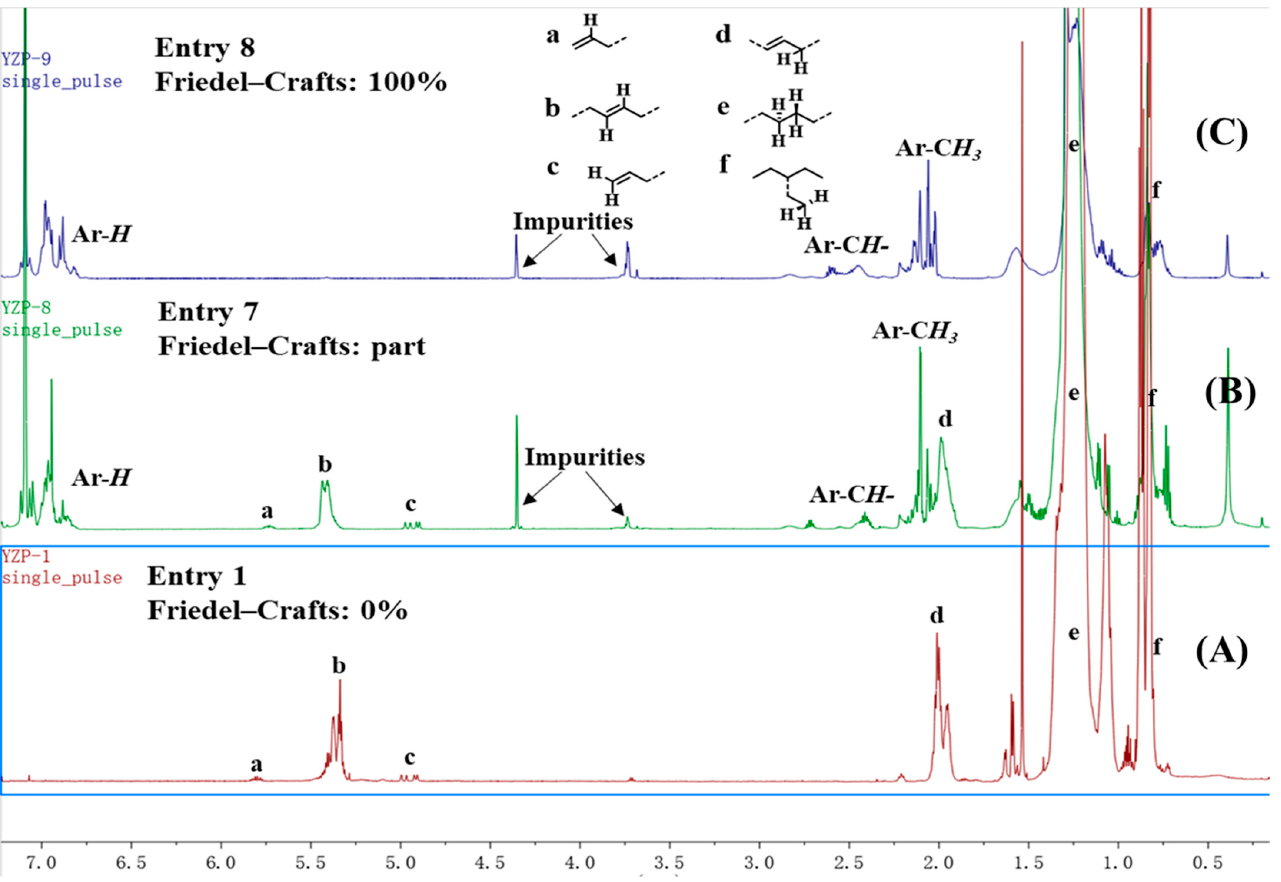
Figure 2. 1 H NMR spectrum (C 6 D 6 ) of representative oligomer samples from Table 1, entries 1 ( A ), 7 ( B ) and 8 ( C ).